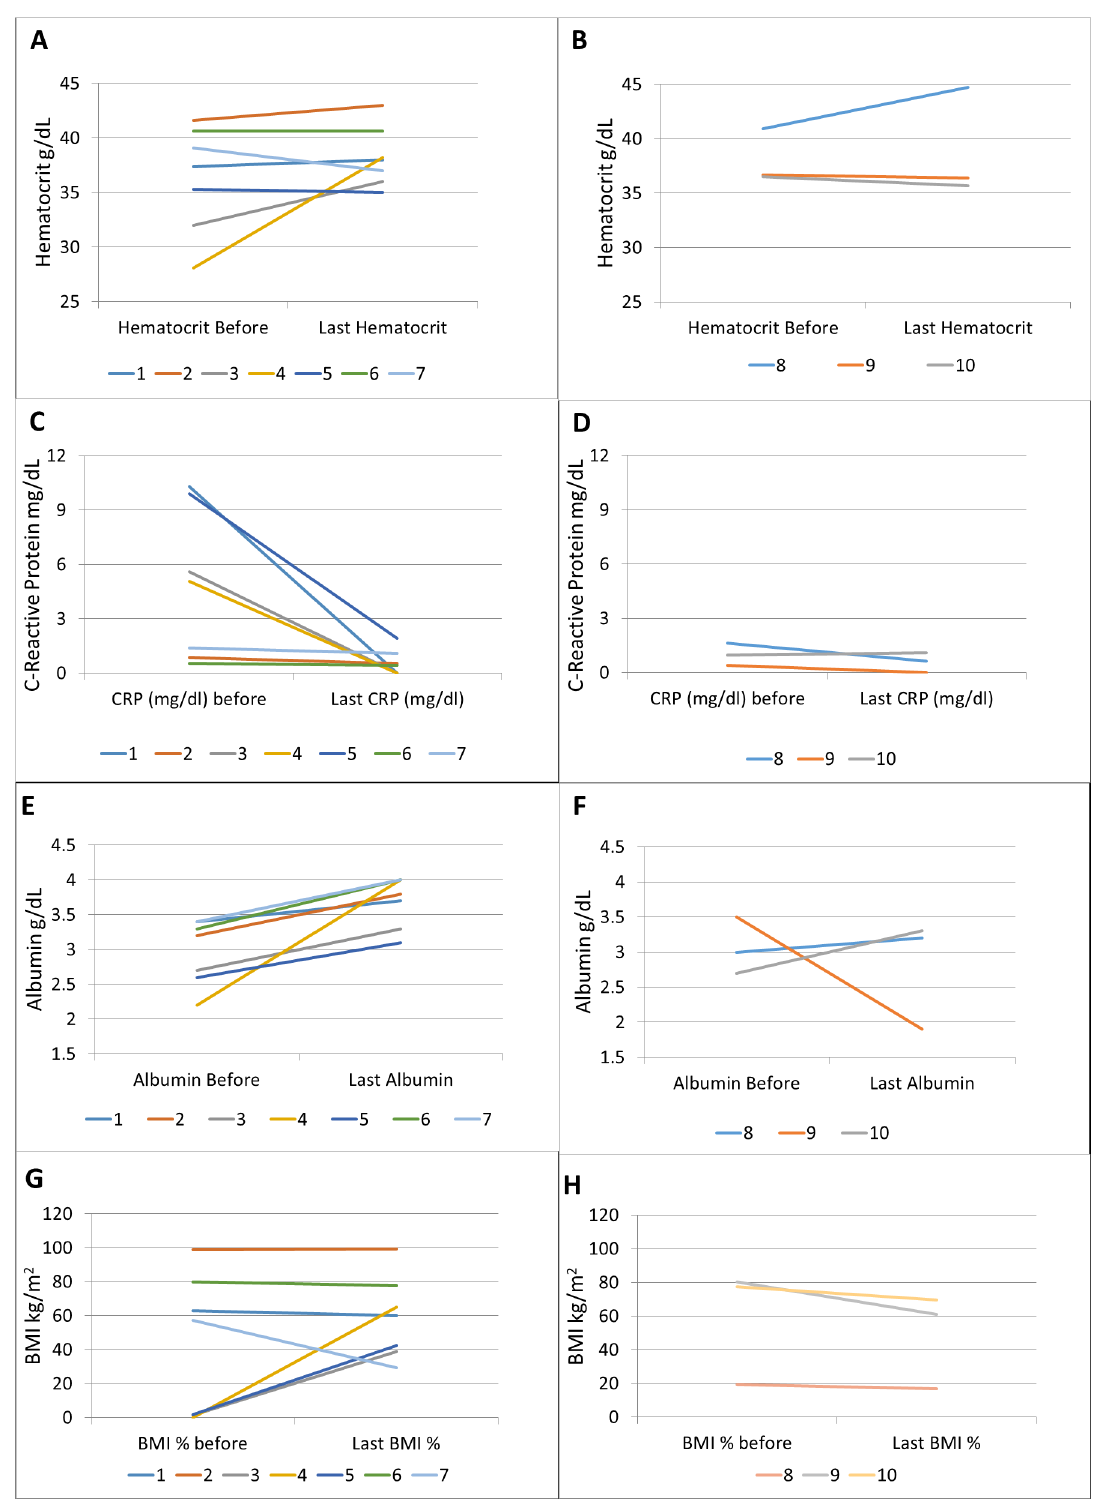
Figure 2. Laboratory and BMI response. Hematocrit in patients with ( A ) augmented dosing and ( B ) Q8 dosing; CRP in patients with ( C ) augmented dosing and ( D ) Q8 dosing; albumin in patients with ( E ) augmented dosing and ( F ) Q8 dosing; BMI in patients with ( G ) augmented dosing and ( H ) Q8